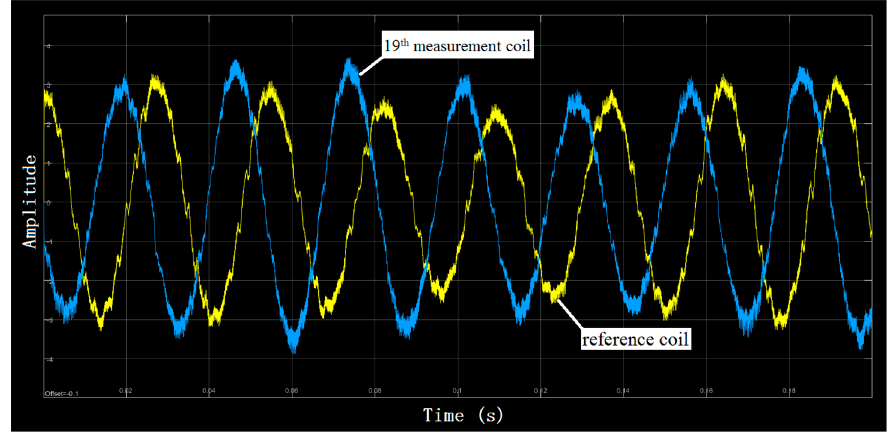
Figure 7. Oscillograph of induced EMF in the 19th measurement coil and reference coil recorded simultaneously.